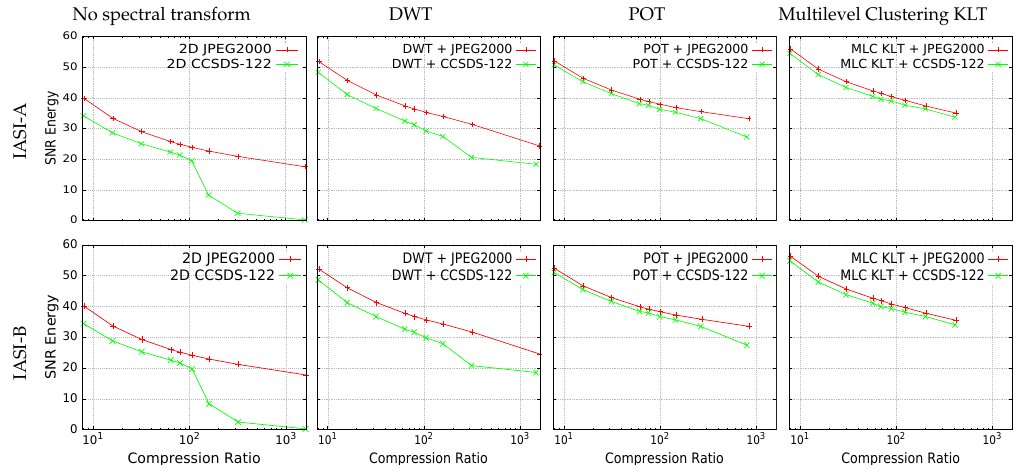
Figure 12. Rate-distortion performance of lossy compression of IASI L1C products. Results report SNR Energy (in dB, higher is better) vs. compression ratio. Results for different spectral transforms are plotted in the columns. In each plot, curves for JPEG 2000 and CCSDS-122.0 performance are displayed. Ranges are the same in all the plots to ease the comparison. Top row: IASI-A products; Bottom row: IASI-B products. POT and Multilevel Clustering KLT are not able to reach such high compression ratios (over 1000:1) as DWT because side-information needs to be transmitted besides the compressed